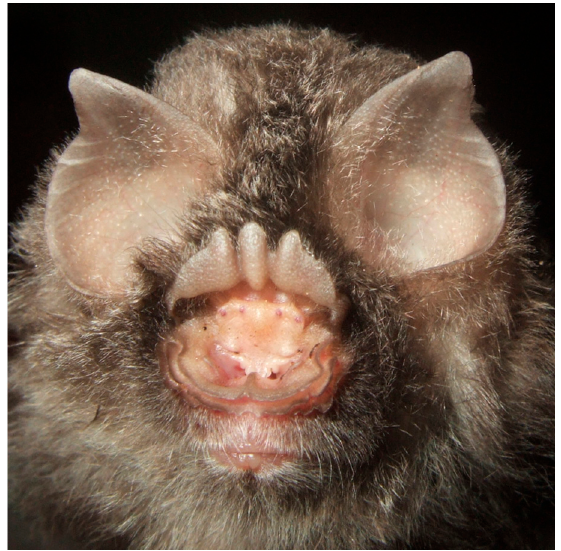
Figure 10. Aselliscus cf. stoliczkanus , adult female. Photograph by Vu Dinh Thong.